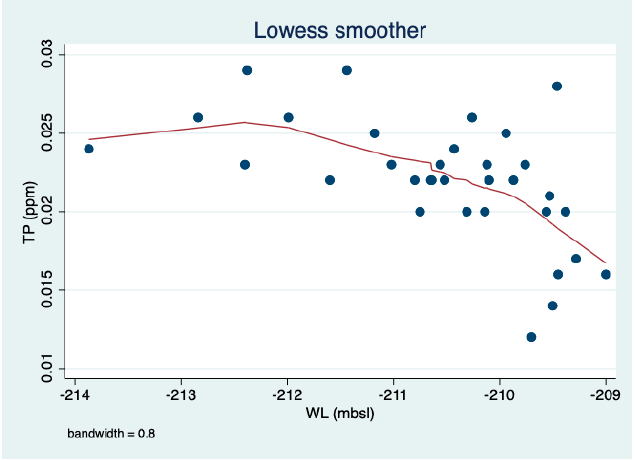
Figure 8. Trend of changes (Lowess smoother, 0.8 bandwidth) of annual lake averages of TP concentration (ppm scale range: 0.01–0.03) vs. WL (mbsl) during 1969–2001.